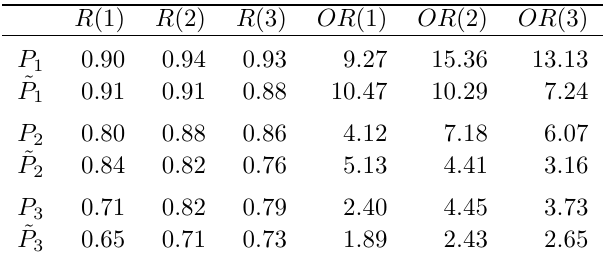
Posterior probabilities R ( h ) = Pr ( Z = h j Z (cid:3) = h ) and posterior odds ratios OR ( h ) for each category of the perturbed variable Z (cid:3) under all